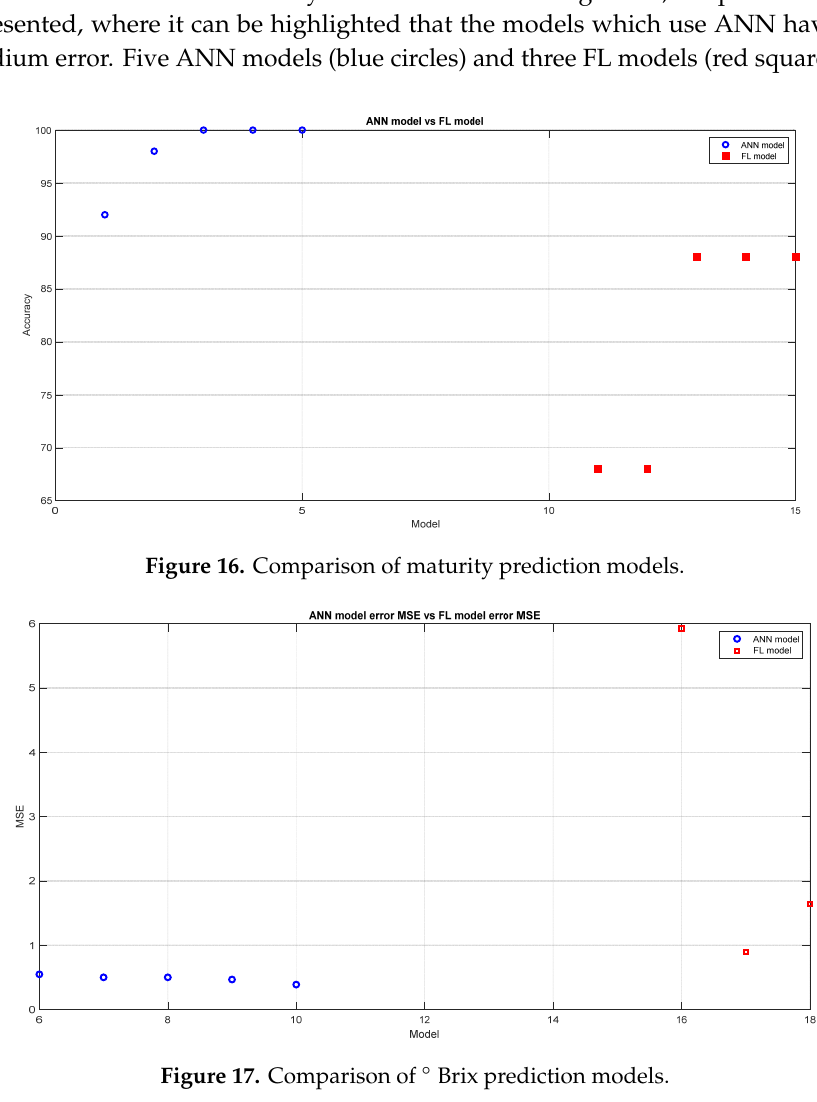
Table 5. Models using FL prediction of ° Brix.